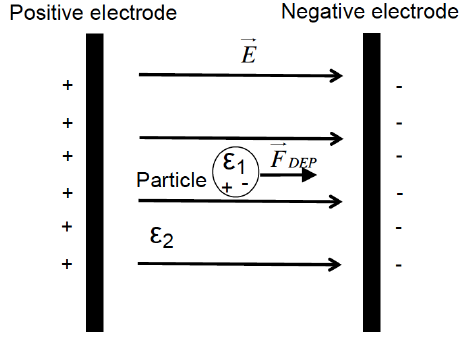
Figure 1. Dielectrophoretic effect using a particle with a permittivity of ε permettivity ε 2